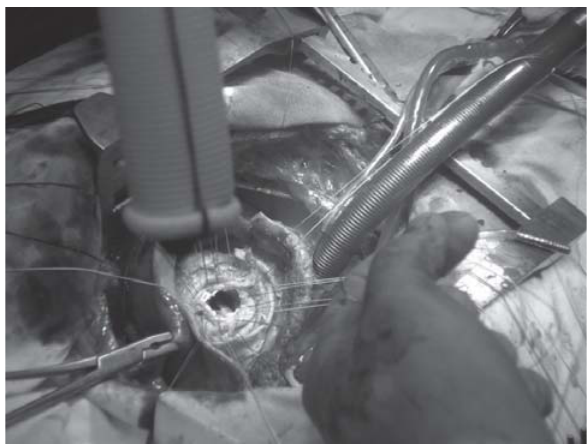
proximalFig. Fig. 3 - Tubo de Dacron posicionado entre a raiz da aorta e seu terço